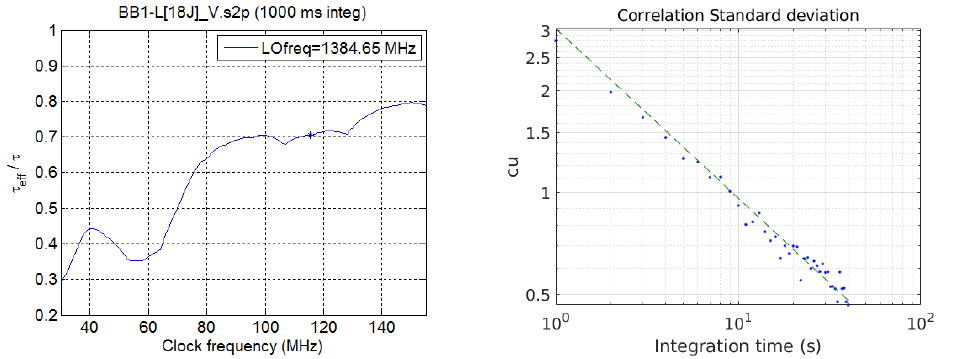
Figure 14. Left: Effective integration time as a function of clock frequency. The actual clock is marked with a star. Right: Standard deviation of measurements as a function of integration